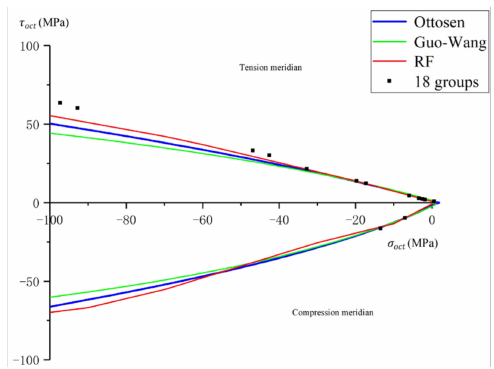
Figure 11. Tension and compression